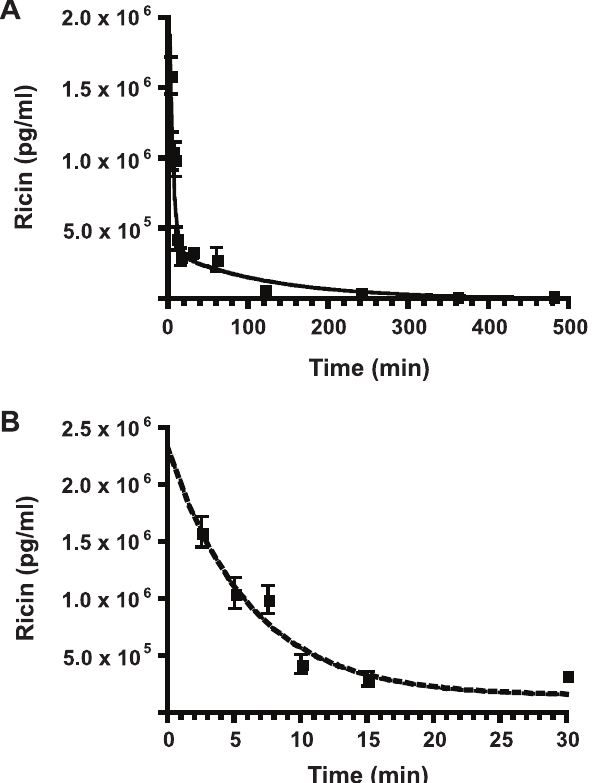
Figure 3. Serum toxicokinetics of ricin. A. Concentrations of ricin in mouse sera over 480 min post -intoxication. Ricin content was determined by IPCR. B. Concentrations of ricin in mouse sera from 2 to 30 min post-intoxication illustrating early and rapid sequestration of ricin with a t 1/2 a half-life of 4 min. Each point in the graph represents the mean value 6 SEM. N $ 5.